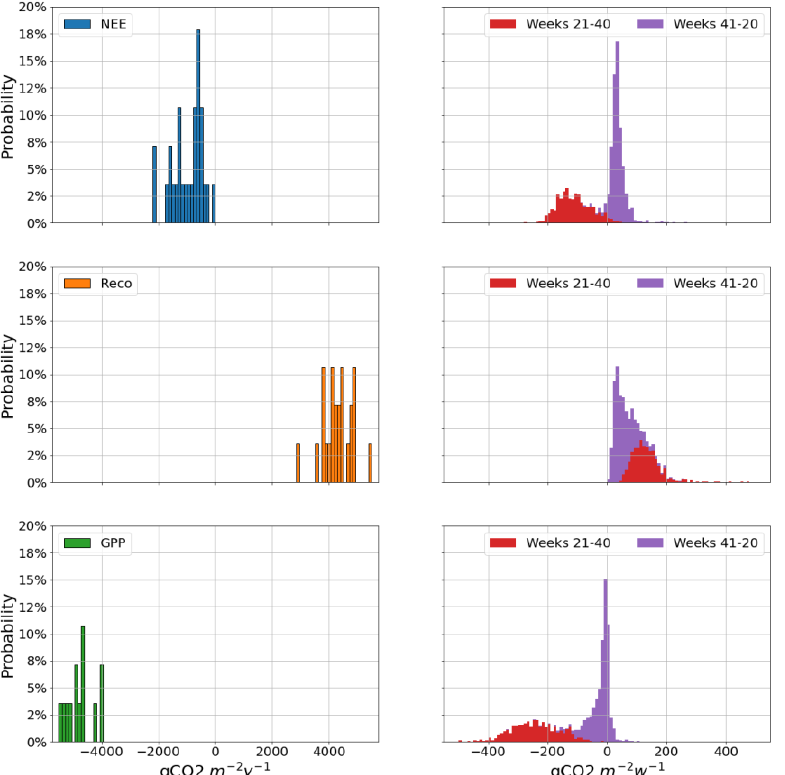
Figure A2. Yearly (left) and weekly (right) NEE (top), R eco (middle), and GPP (bottom) histograms. The growing period starts and finishes around week 20 and 40 respectively (red), while the complement is the dormant season (purple). The relationship between R eco and GPP sums changes each month and each year (Fig- ure A3). However, its correlation is positive, that is, when GPP increases R eco also does, as happened in [94] over all the sites in the Tier 1 FluxNet 2015 dataset. This is because many factors influence both variables in the same way (for example, more leaf area index may result in more photosynthesis, but also more respiration) or are positively correlated (for instance, PAR increases GPP and temperature, which raises the respiration rate). There- fore, it is not possible to increase GPP sums indefinitely without making R eco sums higher.